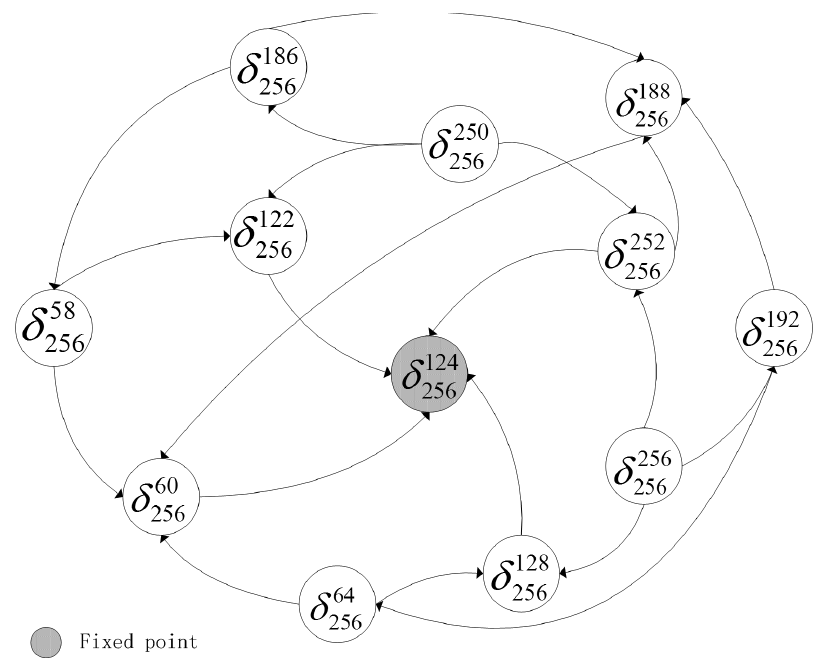
Figure 5. The basin of the fixed point under asynchronous update.